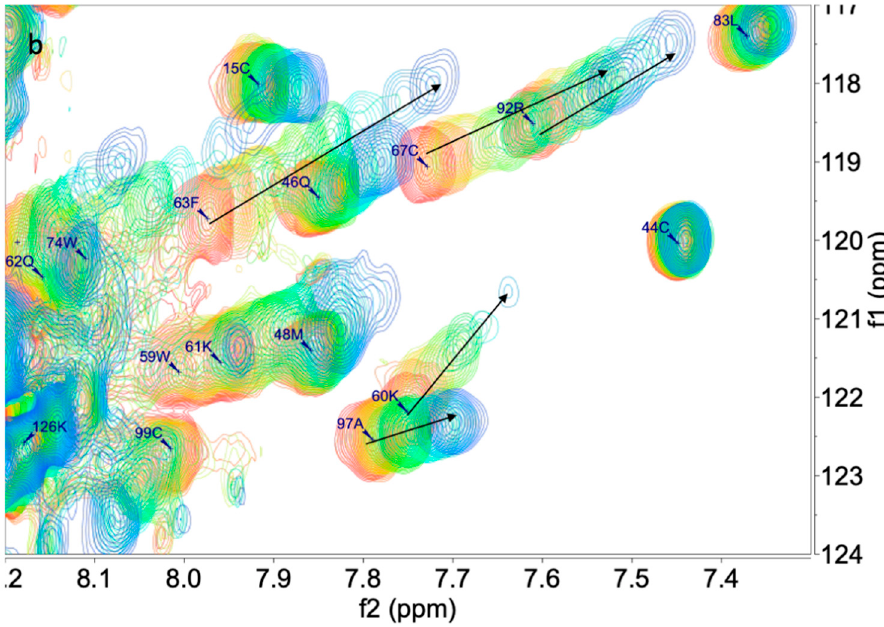
Figure 1. Superimposition of 15 N HSQC spectra of PTN in presence of 1 ( a ) at 0.0, 0.2, 0.4, 0.6, 0.8, 1, 1.5, 2.0, and 3.0 equivalents and 2 ( b ) at 0.0, 0.2, 0.4, 0.6, 0.8, 1, 1.5, 2.0, 3.0, and 4.0 equivalents.